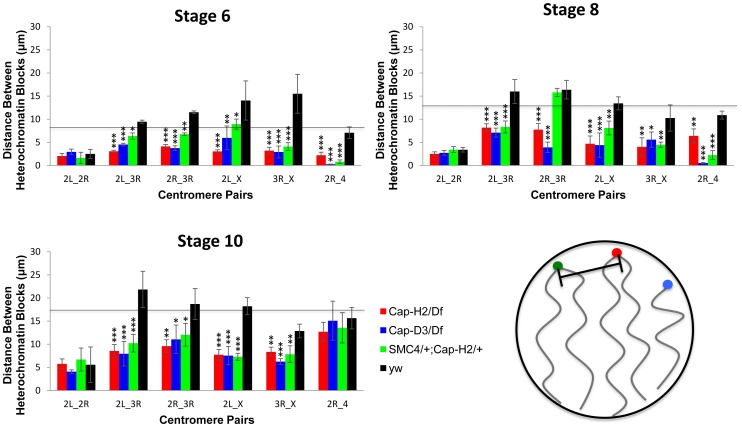
Condensin II promotes the dispersal of heterologous centromeres.The mean distances between the peri-centric microsatellite sequences of the X, 2R, 2L, 3R and 4 chromosome arms at various stages of nurse cell development are shown. The labels below each set of four bars indicate which pair of loci are being compared. The genotypes assayed were Cap-H2Z3-0019/Df(3R)Exel6159, y[1] w[67c23]; P(w[+mC] = lacW)glu[k08819]/+; Cap-H2Z3-0019/+, Cap-D3EY00456/Df(2R)Exel7023, and wild type (y[1] w[67c23]). Error bars correspond to standard errors. One asterisk signifies p<.05, two asterisks signifies p<.01, and three asterisks signifies p<.001. The cartoon in the lower right panel illustrates the distance measurements being made between different heterochromatin FISH signals.